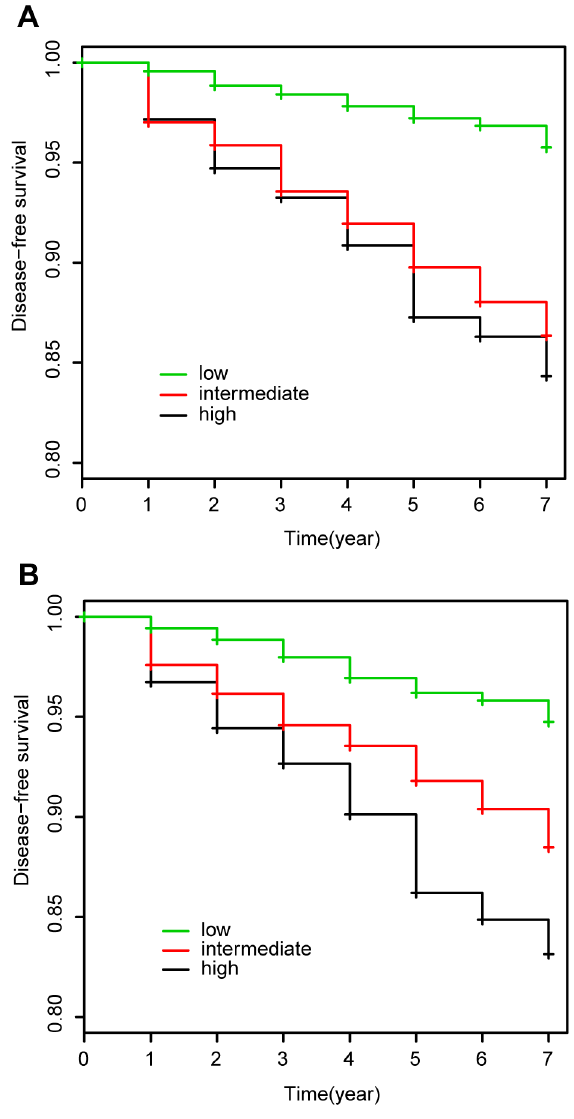
Figure 5. Cumulative disease-free survival in a prospective cohort. Models using (A) only clinical risk factors and (B) both of clinical and genetic risk factors.